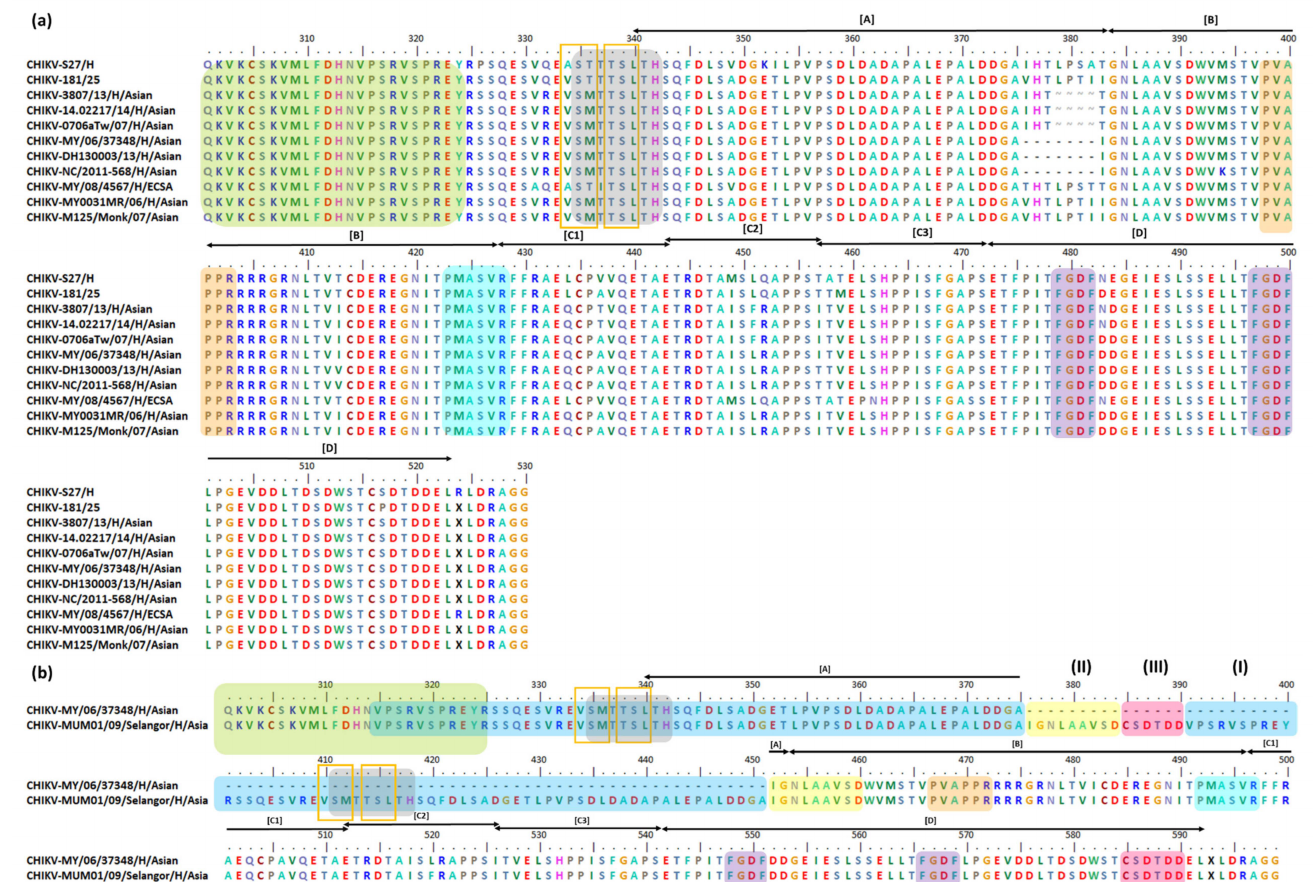
Figure 2. Important motifs and mutation events in CHIKV nsP3 HVD. The HVD starts at position 325. It has one P-rich region at positions (i) 388–393 ( a ) or (ii) 467–472 ( b ) (peach) and two FGDF-like motifs at positions (i) 479–482 and 497–500 ( a ) or (ii) 548–551 and 566–569 ( b ) (purple). For the fragment A of certain CHIKV strains, there is a 4 aa deletion at position 379–382 and a 7 aa deletion at position 376–382 ( a ). For CHIKV MUM001–2009-Selangor, there is a 76 aa duplication event at position 376–456 ( b ). The 76 aa duplication motif is indicated as motif (I) at position 391–456 (blue), motif (II) at position 376–384 (yellow), and motif (III) at position 385–390 (red). The template positions as follows: motif (I) 315–375; motif (II) 452–460; and motif (III) 585–590 ( b ). The PMASVR motif is at position 423–428 ( a ) or 491–497 ( b ) (turquoise), while the Ae. aegypti S(M/T)(T/I)TSLTH motif is at position 335–342 ( a ), and its duplicate is at positions 335–342 and 411–418 ( b ) (gray). Short motifs are possibly conserved/inserted/repeated/duplicated among CHIKV strains; the (V/A)S(M/T) and TSL are at positions 334–336 and 338–340 ( a ) and 410–412 and 414–417 ( b ) (orange boxes). Interestingly, these motifs are located in the Ae. aegypti inserted S(M/T)(T/I)TSLTH